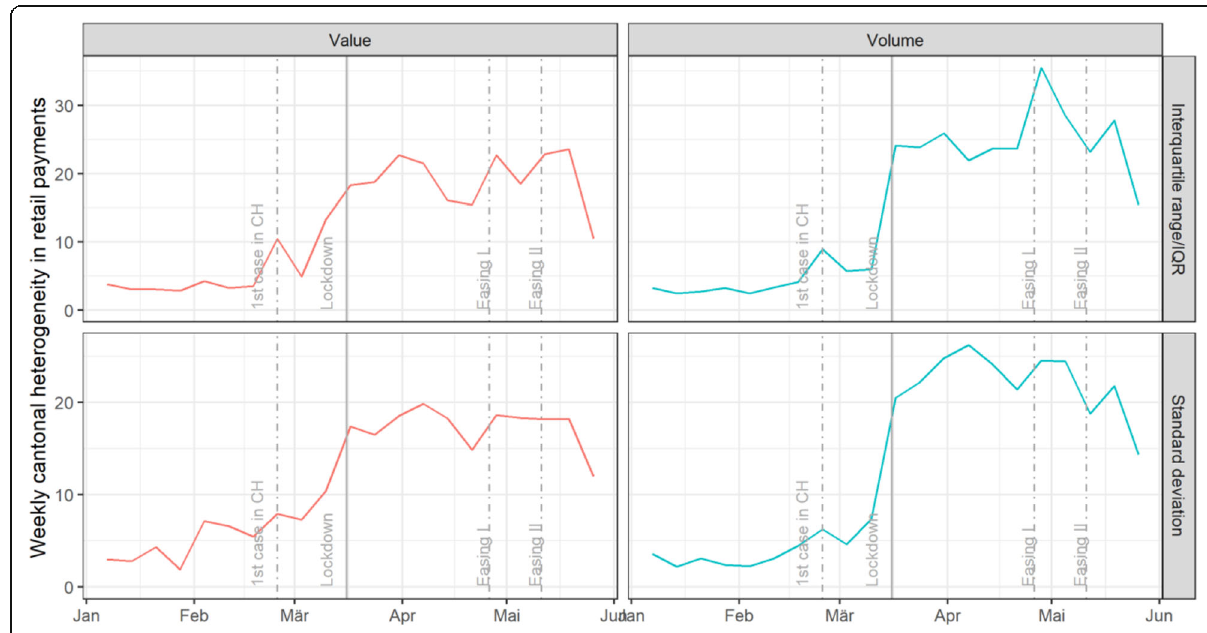
Fig. 12 Weekly measures of heterogeneity of excess retail card payments among cantons. Source: Own calculations, Worldline/SPS